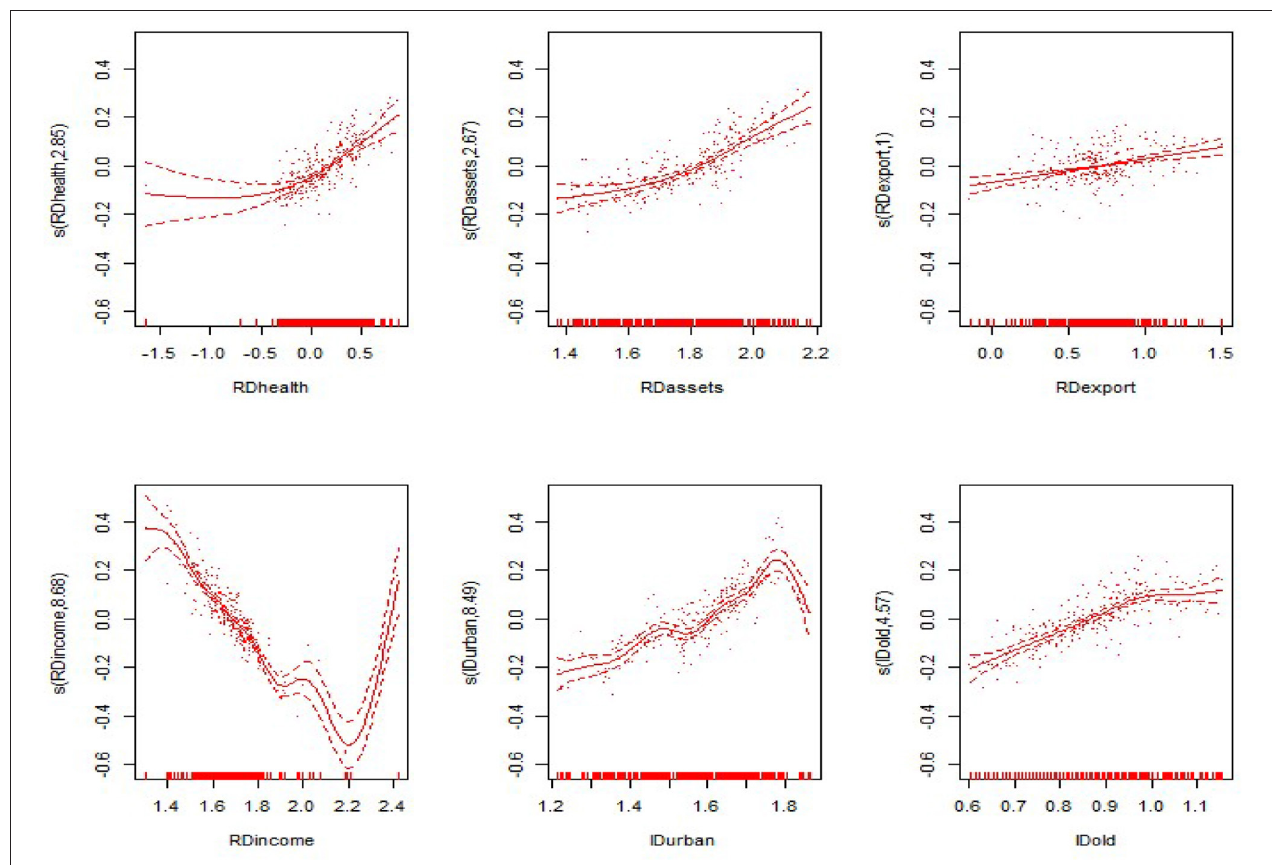
FIGURE 10 | Comprehensive effects of the explanatory variables on per capita GDP in the western